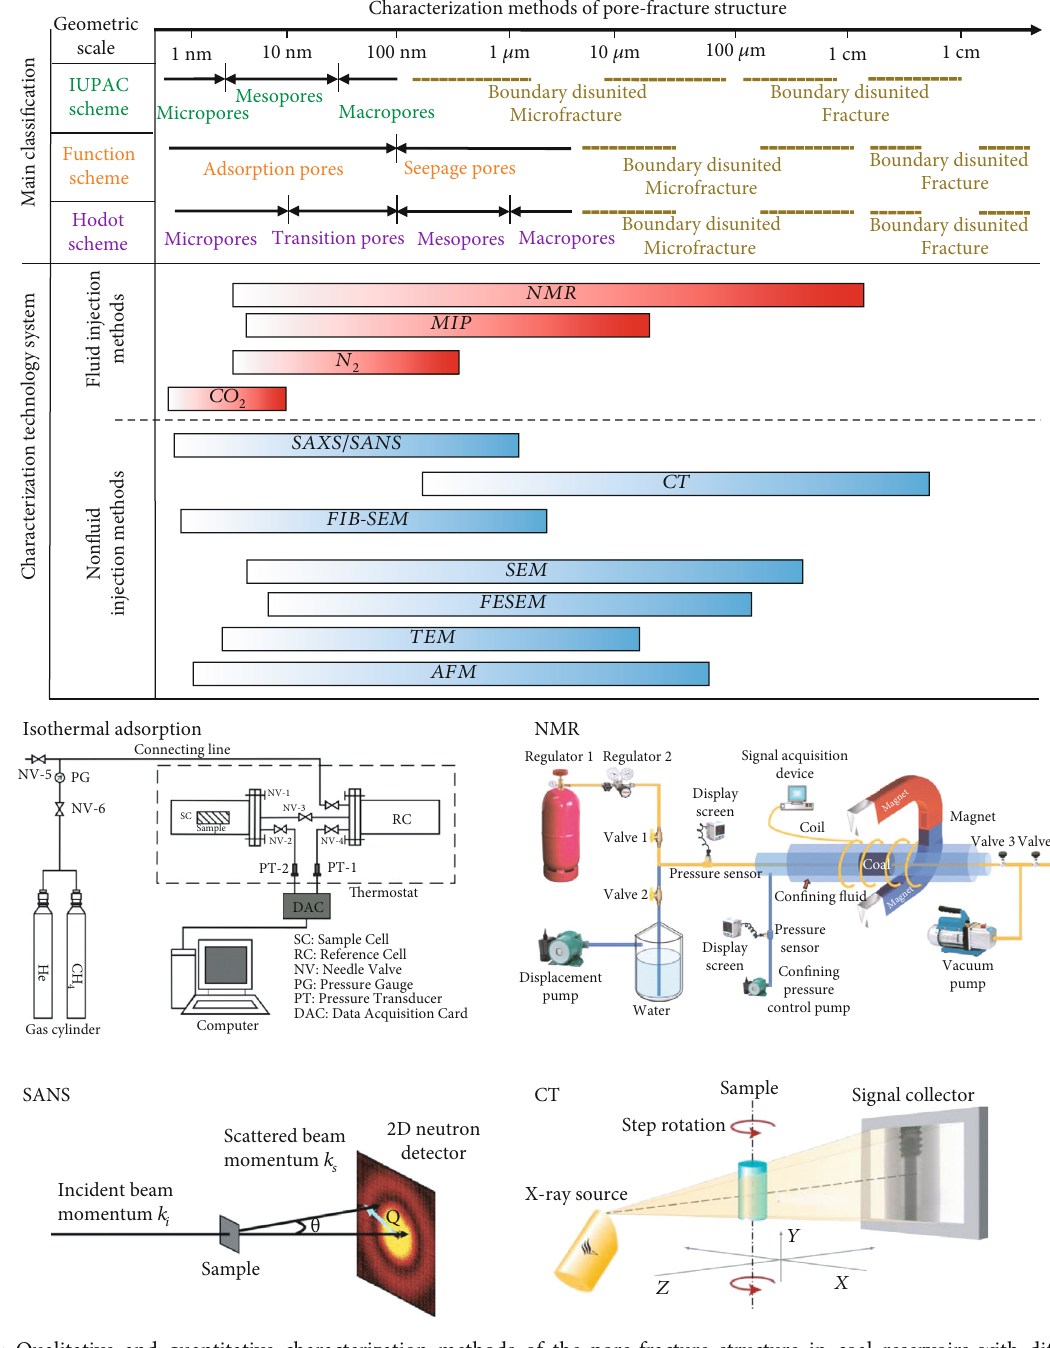
Figure 4: Qualitative and quantitative characterization methods of the pore-fracture structure in coal reservoirs with di ff erent scales (modi fi ed from Yu et al.